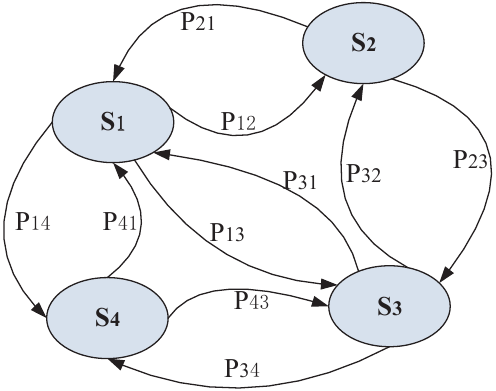
Figure 4. Discrete-time Markov chain